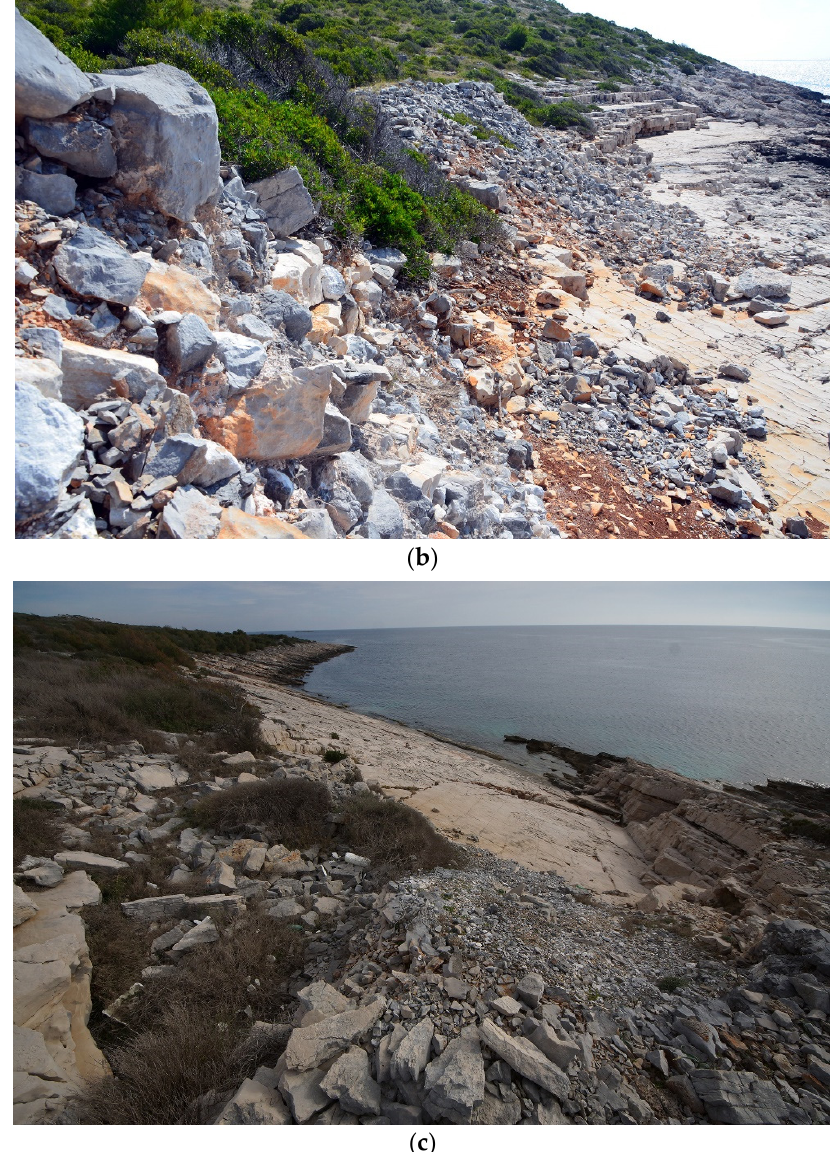
Figure 4. Remnants of lime kilns on three islands in northern Dalmatian (photo by J. Kale): ( a ) Orut, ( b ) Levrnaka, and ( c ) Žirje. The photographs depict only the remains of burnt stones and rubble at the extraction site of stones that had been arranged in the form of a kiln nearby, because the actual lime kilns have not been preserved.